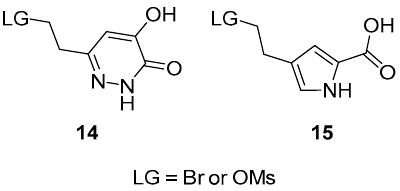
Figure 6. Selected headgroups for the synthesis of lid-open DAAO inhibitors.